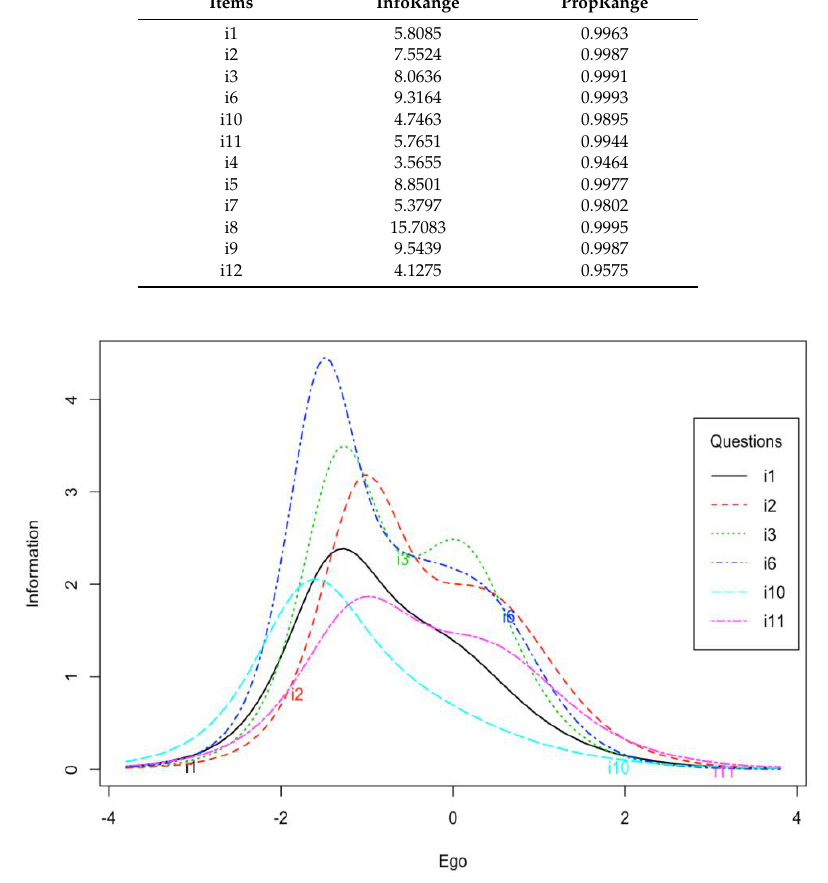
Table 1. The values of information function for Perception of Success Questionnaire (POSQ) test items. Items